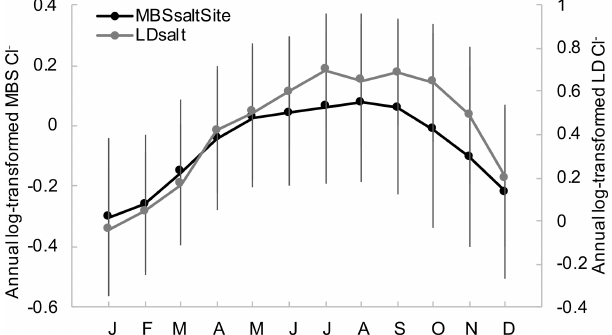
Figure A3. Climatology of the annual log-transformed sea salt con- centrations for the Mount Brown South site average (MBSsaltSite) and Law Dome (Dome Summit South site; LDsalt) over the period 1975–2015/2016. Error bar vertical line plots give the 1 σ range of the composite monthly means.